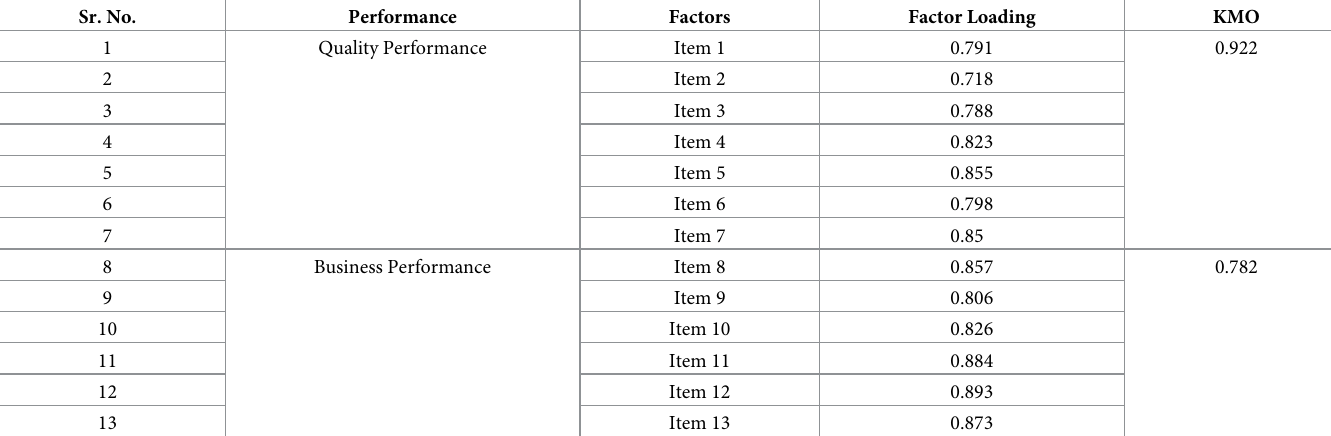
Table 7. Factor loading for performance of hospitals. Sr. No.